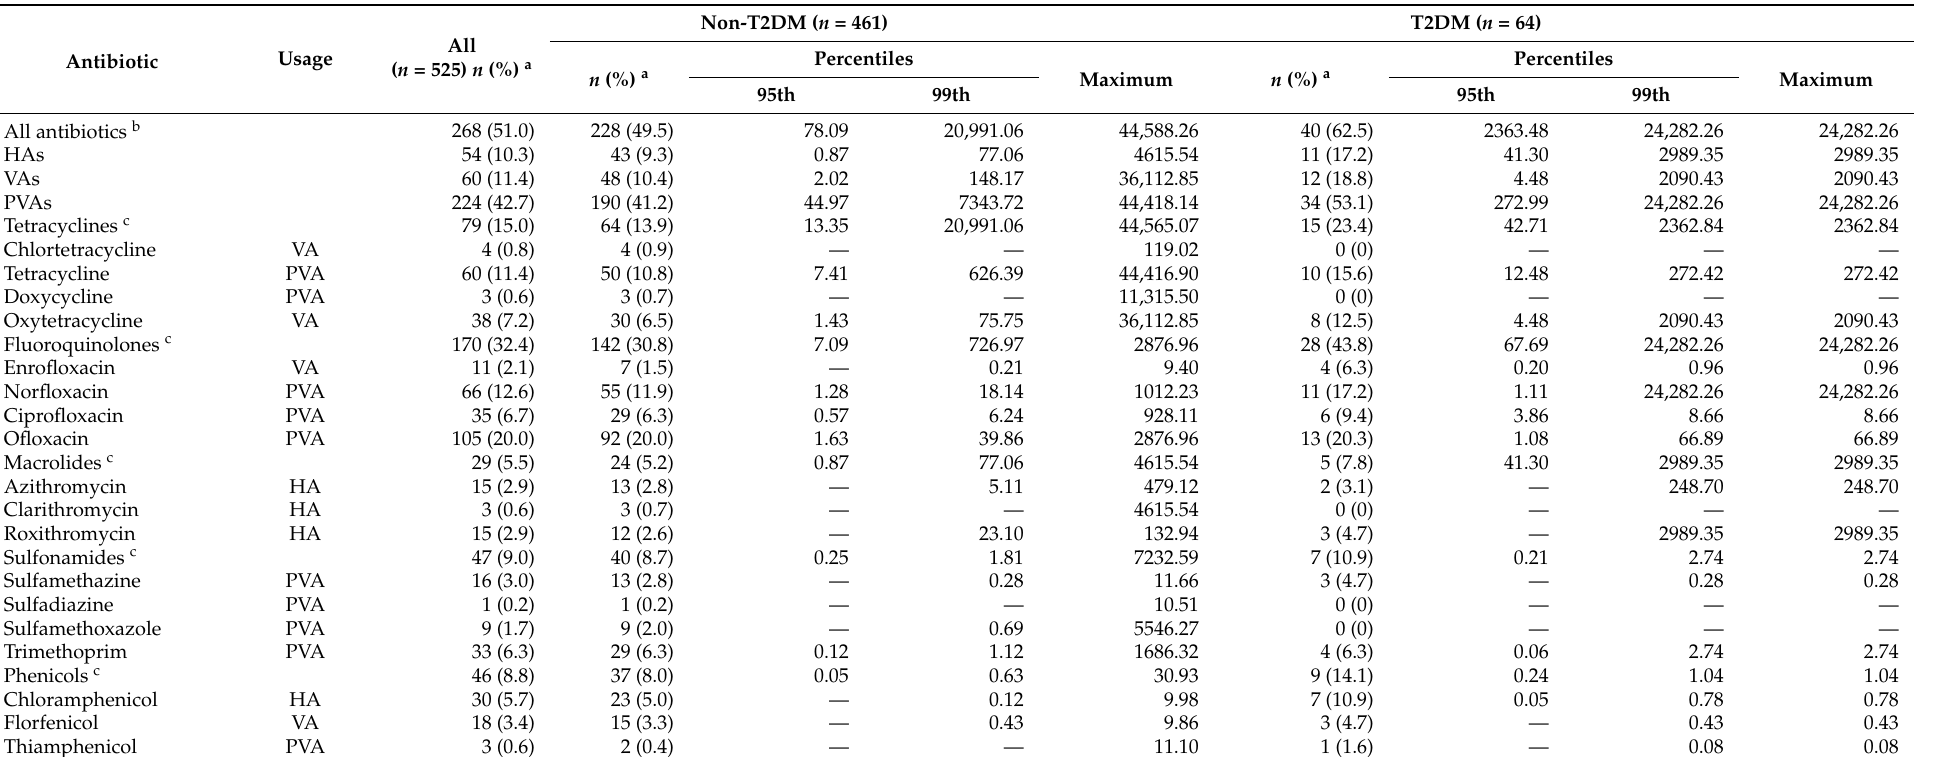
Table 1. Frequency and concentration distribution of antibiotics detected in the urine of middle-aged and older people with and without type 2 diabetes in Xinjiang ( n =